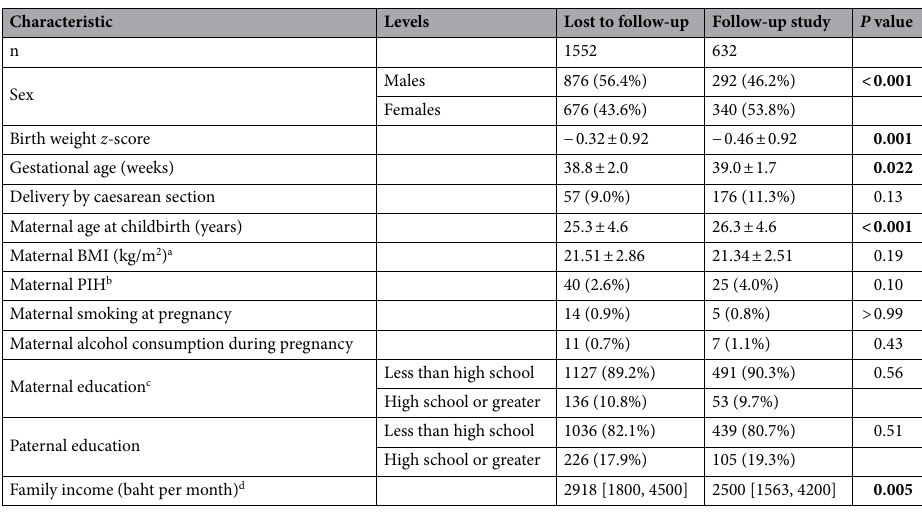
Table 1. Comparisons of demographic and birth characteristics between our study population and the original study participants who were lost to follow-up. Continuous data are means ± SD or median [quartile 1, quartile 3], as appropriate; categorical data are n (%). BMI body mass index, PIH pregnancy-induced hypertension. P values that are statistically significant (at p < 0.05) are shown in bold. a BMI recorded at